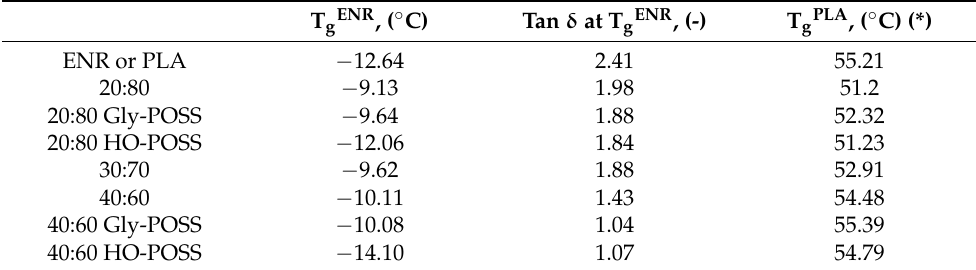
Figure 11. Loss tan δ ( − ) as a function of temperature ( ◦ C) for PLA/ENR ( a ) and POSS modified blends ( b ). Table 1. Glass transition temperature T g of ENR and PLA phase for PLA/ENR